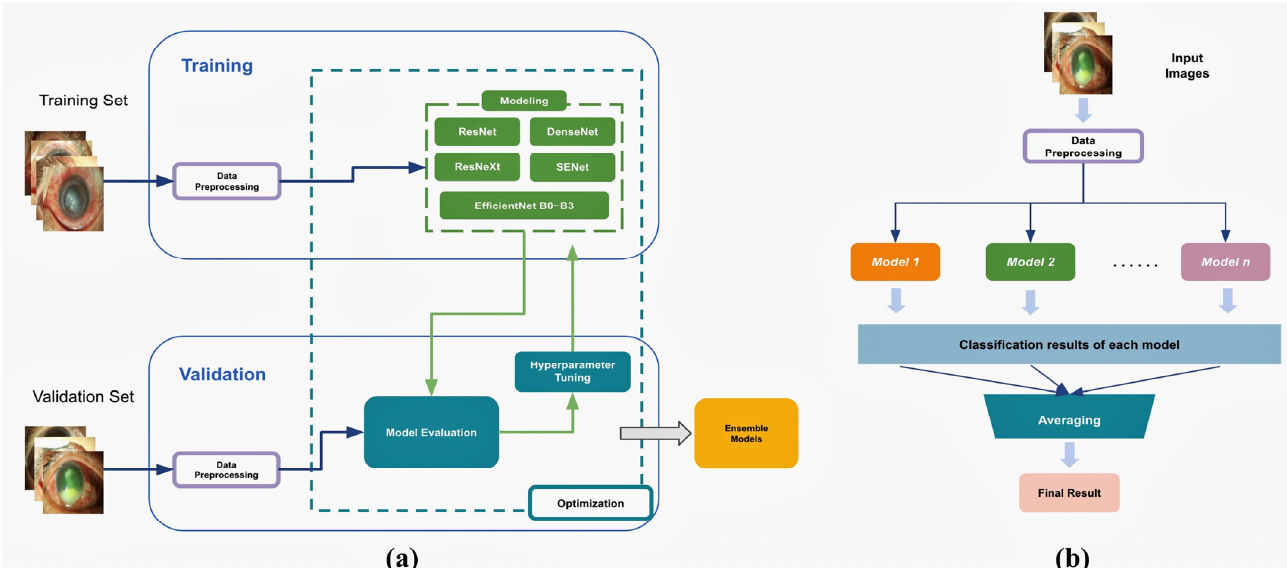
Figure 2. The framework of deep learning models for identifying Pseudomonas keratitis by external eye photographs. ( a ) The input images were split into training and validation sets. ResNet50, ResNeXt50, DenseNet121, SE-ResNet50, and EfficientNet B0, B1, B2, and B3 were adopted as the constituent backbone models. After data preprocessing, we optimize the framework through training CNN-based backbone models, evaluating the validation set, and hyperparameter tuning. The optimized models were used for the further ensemble process. ( b ) The ensemble model combines n predicted probabilities from various models and calculates the average probability. Here, “ n ” represents the number of models selected in the ensemble